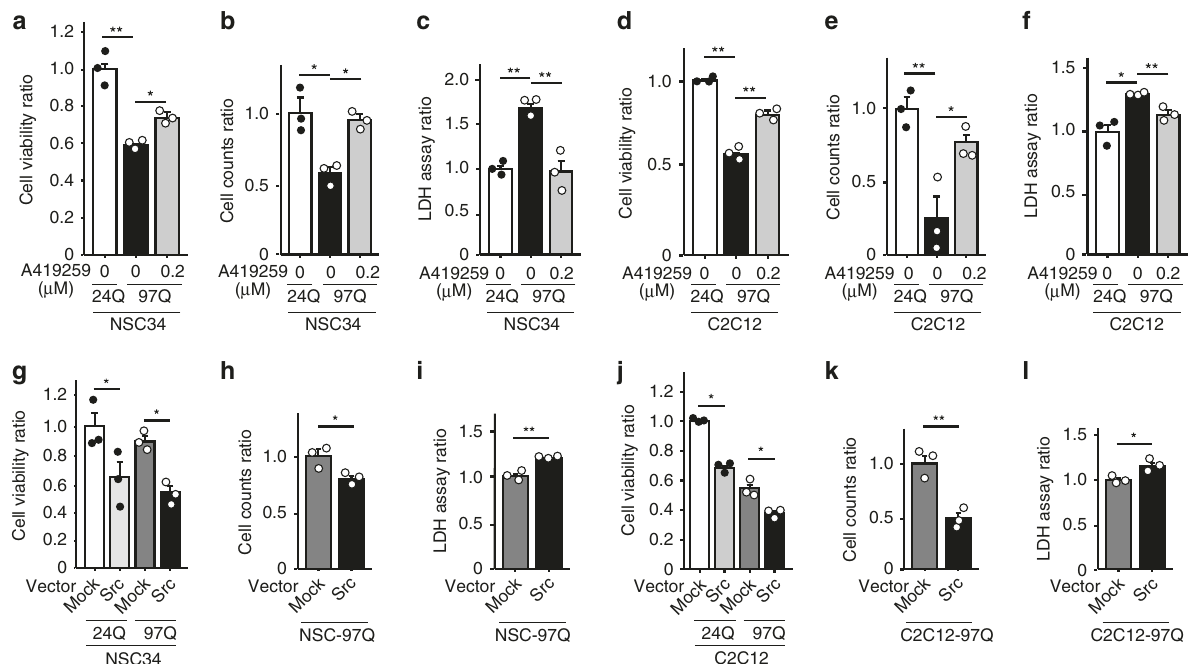
Fig. 3 Src kinase inhibition improves the viability of cellular models of SBMA. a – f The viability, cell numbers and LDH release from NSC34 ( a – c ) and C2C12 cells ( d – f ) stably expressing AR-24Q or AR-97Q that were treated with or without A419259 are shown. g The viability of the NSC34 cells stably expressing AR-24Q or AR-97Q transfected with mock or Src plasmids. h , i The cell numbers ( h ) and LDH release ( i ) from the NSC34 cells stably expressing AR-97Q transfected with mock or Src plasmids are shown. j The viability of the C2C12 cells stably expressing AR-24Q or AR-97Q transfected with mock or Src plasmids. k , l The cell numbers ( k ) and LDH release ( l ) from C2C12 cells stably expressing AR-97Q transfected with mock or Src plasmids are shown. DHT was added to the cell culture medium in every assay. Quantitative analyses were performed on n = 3 samples per group. Error bars indicate the s.e.m. * p < 0.05 and ** p < 0.01, un p aired two-sided t -test ( b , c , e , f , h , i , k , l ), ANOVA with Dunnett ’ s test ( a , d) or ANOVA with Tukey ’ s test ( g , j ). Source data are provided as a Source Data fi le ( a – l